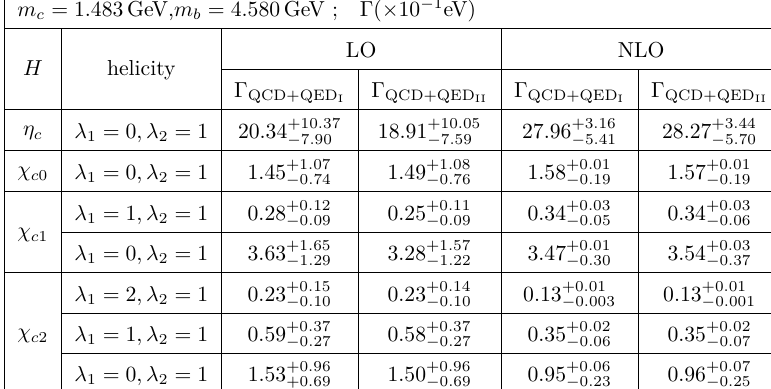
Table 5 . Comparison on the decay widths between the two QED schemes. The decay widths include the contributions from QCD, QED, and the interference. In Γ QCD+QED contributions are computed in the QED I scheme, and in Γ QCD+QED are computed in the QED II scheme. We estimate the uncertainties by sliding µ R from 2 m c to 2 m b